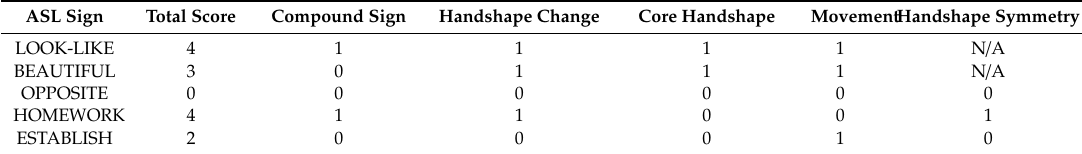
Table A3. Sign-copying task complexity score